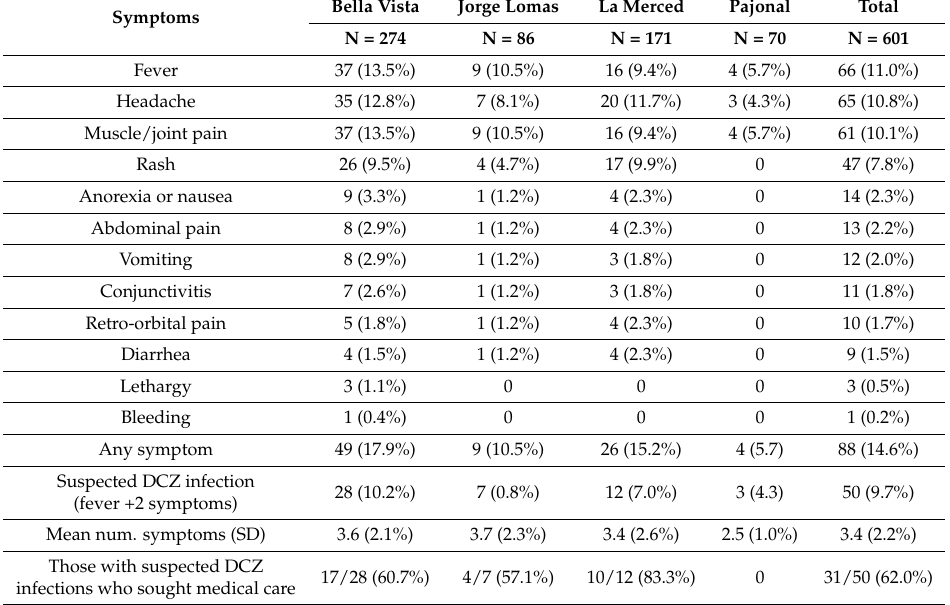
Table 4. Prevalence of dengue, chikungunya or Zika fever (DCZ) symptoms by study site; respondents (n and %) who reported DCZ symptoms in the post-earthquake period, those who were defined as suspected DCZ infections (fever plus two additional symptoms), and individuals with suspected DCZ infections who sought medical